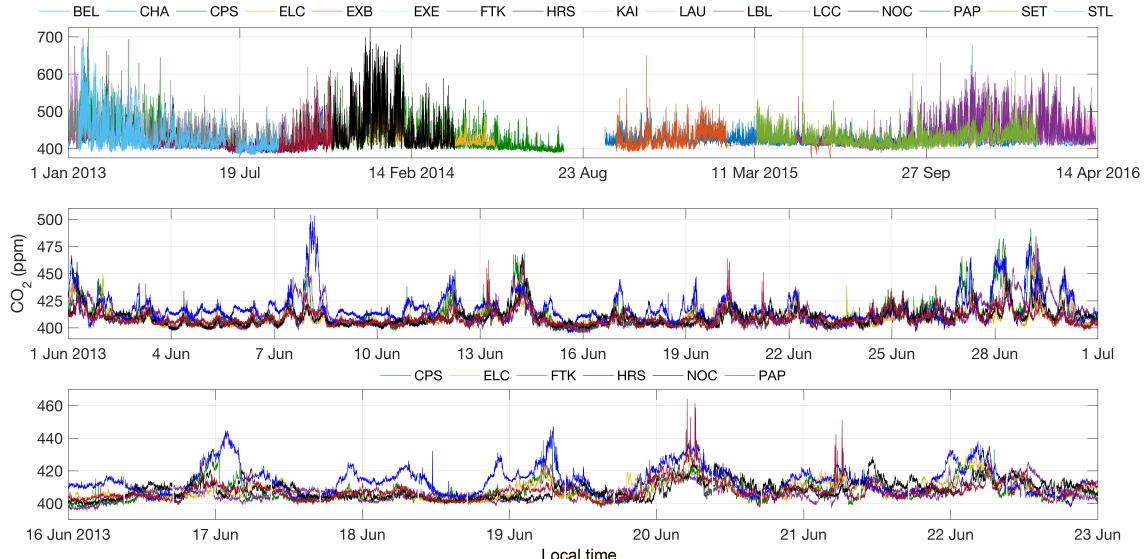
Figure 9. Time series of drift- and bias-corrected CO 2 dry air mole fractions collected over the course of ∼ 2.5 years at 16 BEACO 2 N sites (top), 1 month at six representative sites (middle), and 1 week at the same six sites (bottom). The hiatus around 23 August corresponds to a large-scale hardware refurbishment effort that began in mid-2014.